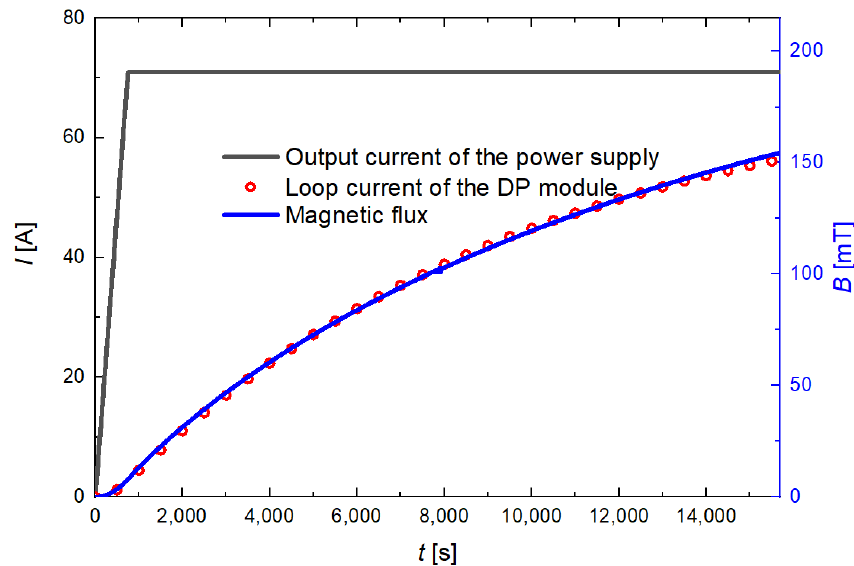
Figure 16. Output current from the power supply, as well as the measured magnetic flux and the calculated loop current of the DP